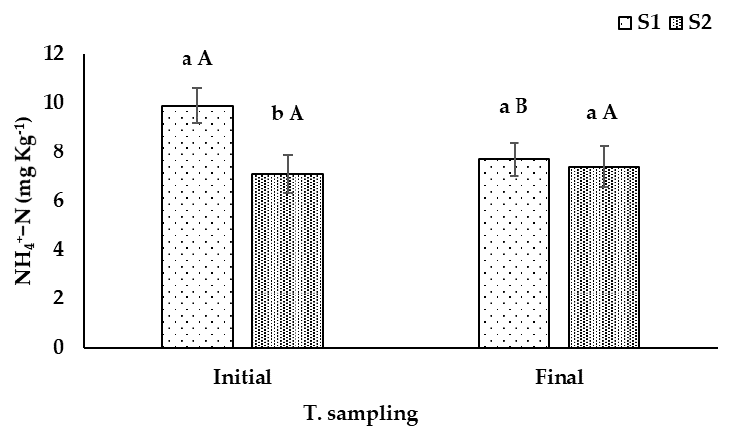
Figure 2. Interaction between time of sampling (initial and final) and soil type (soils S 1 and S 2 ) for soil NH 4+ -N concentration (mg kg − 1 ). Lowercase letters are used for the comparison between soil type in each time of sampling and uppercase letters are used for the comparison between time of sampling for each soil type.